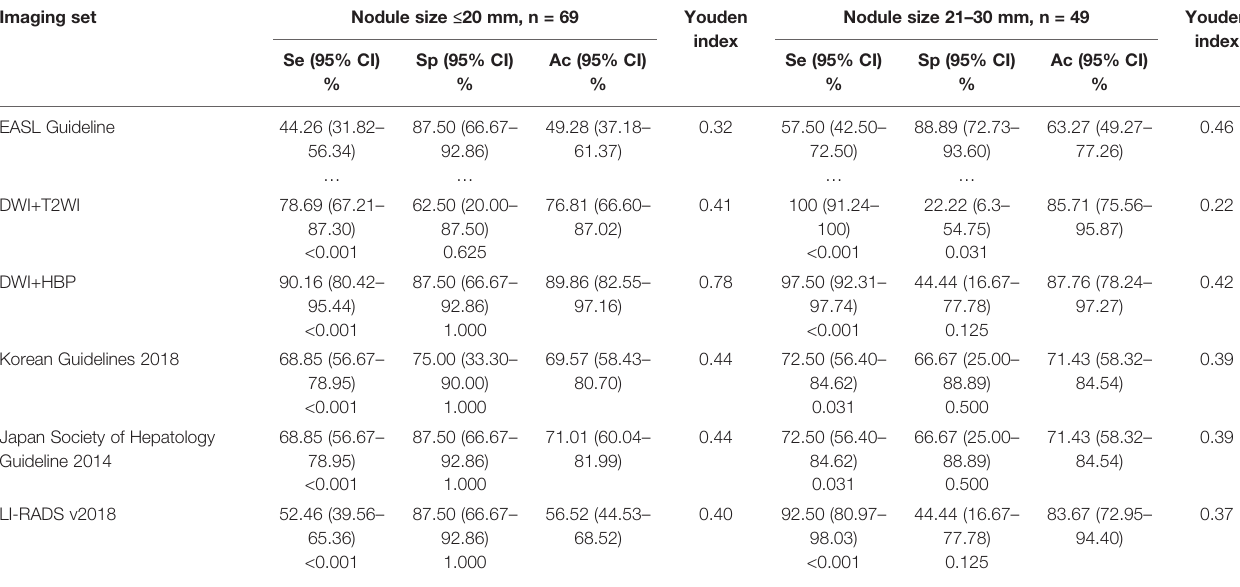
TABLE 3 | Diagnostic performance of these criteria using HBSC-MRI with different tumor size. Imaging